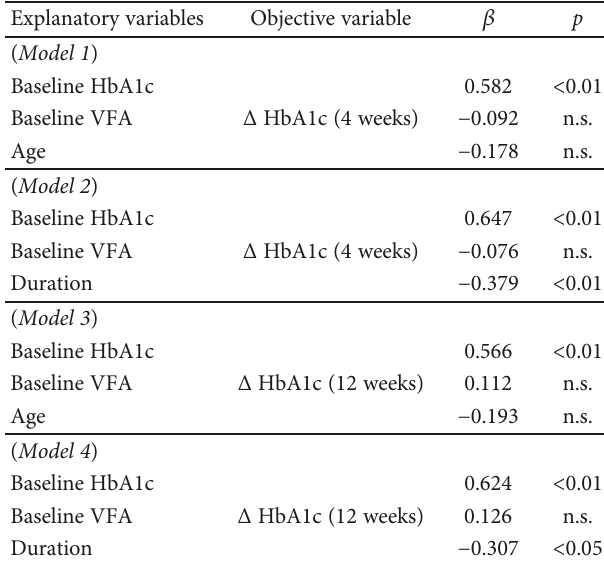
Table 4: Determinant factors for the e ffi cacy of tofogli fl ozin in multivariate